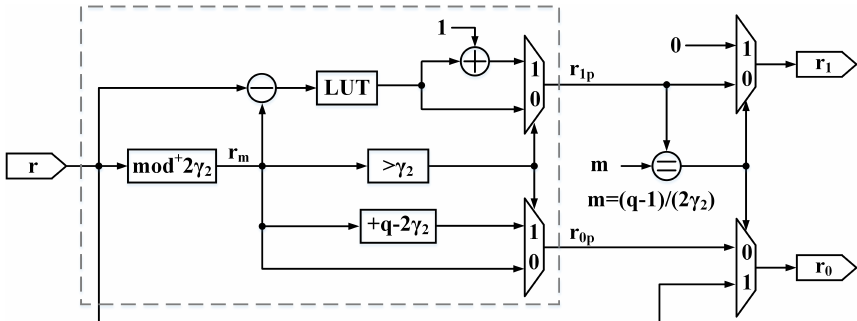
Figure 11: Structure of the proposed Decompose